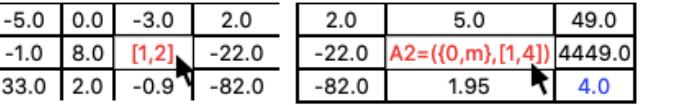
Figure 12. The mouse cursor at the position without the agent (on the left) and at position of the agent (on the right).